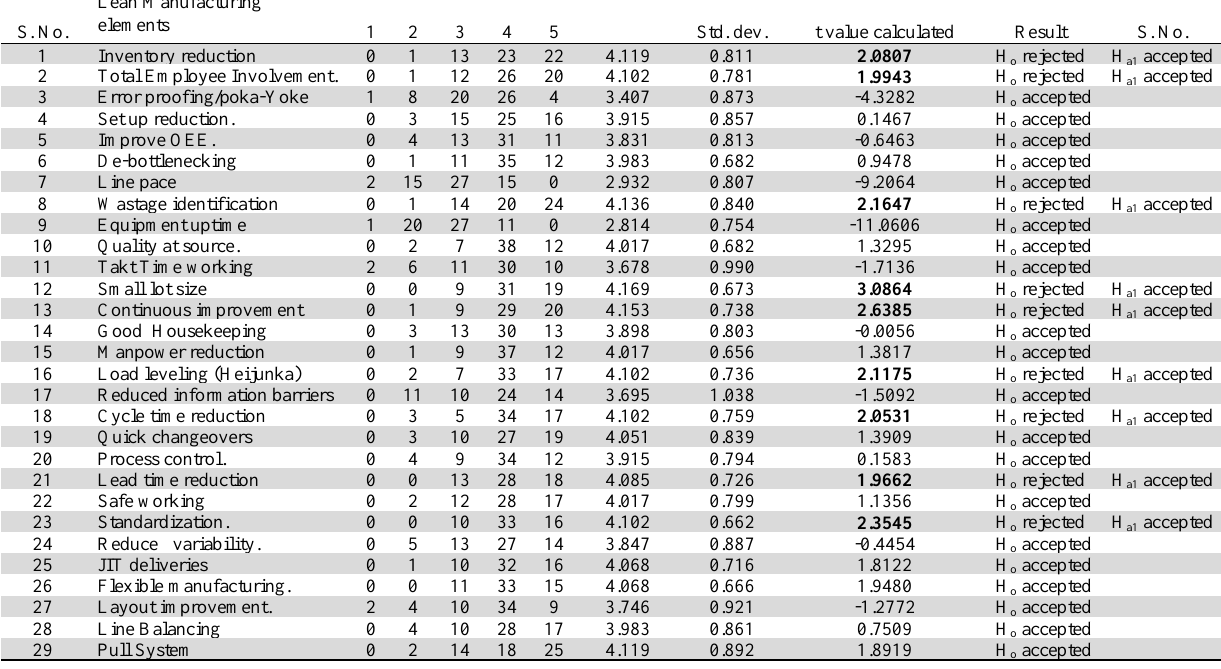
Significance of Lean manufacturing elements in Indian industry S.